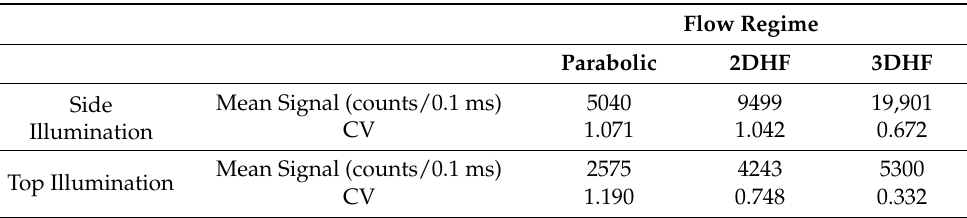
Figure 11. ( a ) The modeled excitation region for the side-illuminated biosensor with a 3DHF flow regime; ( b ) The simulated signal distribution, with the furthest-right skew of all devices in the side-illumination format. Table 3. Summary of simulation signals for each design model.